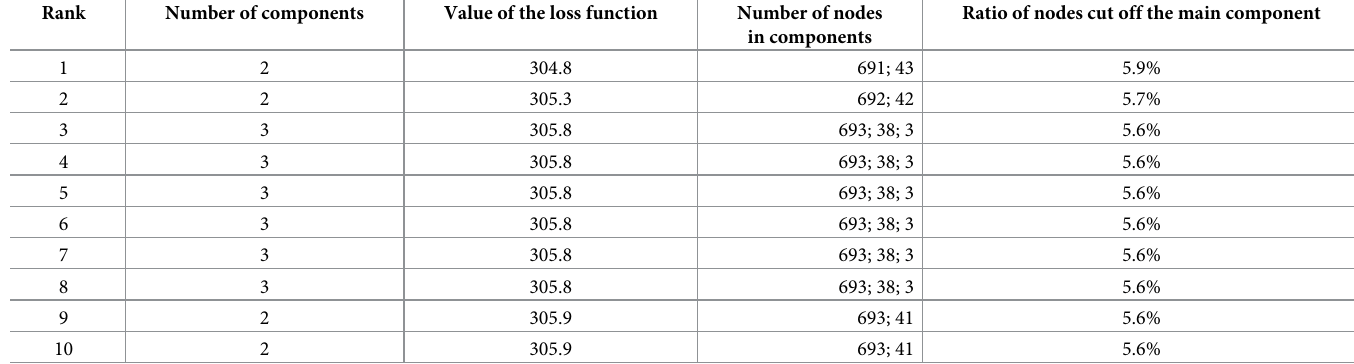
Table 4. The worst-case scenarios for the Zlı´n region.